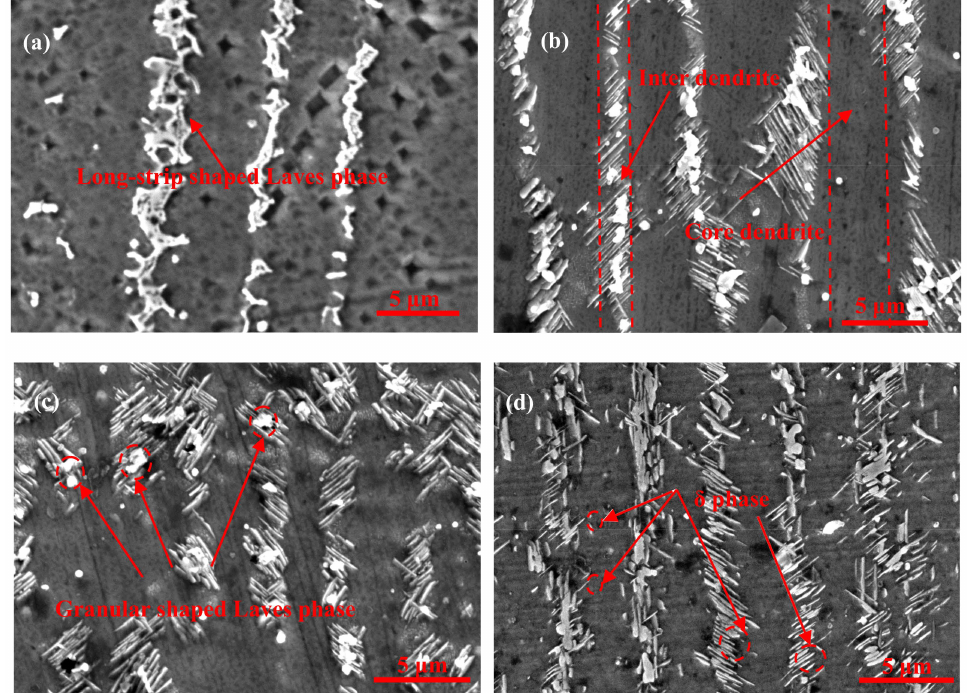
Figure 2. The morphology and distribution of the δ phase after aging at 950 ◦ C for di ff erent aging times for samples fabricated without electromagnetic stirring: ( a ) the as-deposited sample, ( b ) aging for 1 h, ( c ) aging for 4 h, and ( d ) aging for 16 h.